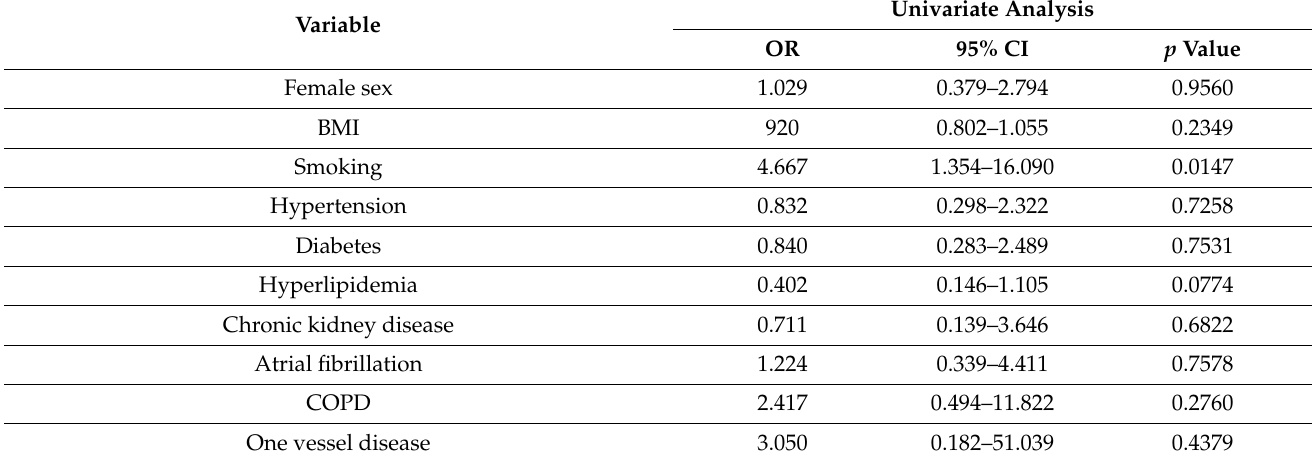
Table 7. Logistic regression analysis of predictors of ERO > 10 mm2 in CABGa